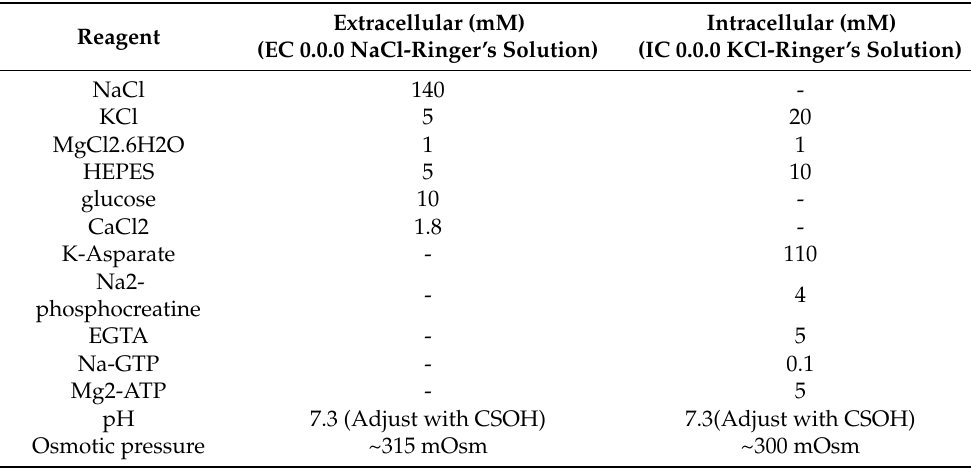
Table 8. Composition of intracellular fluid and extracellular fluid (action